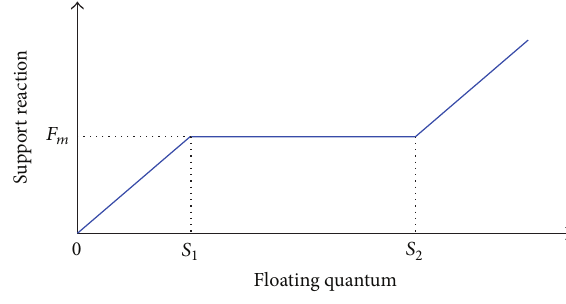
Figure 5: The schematic of supporting